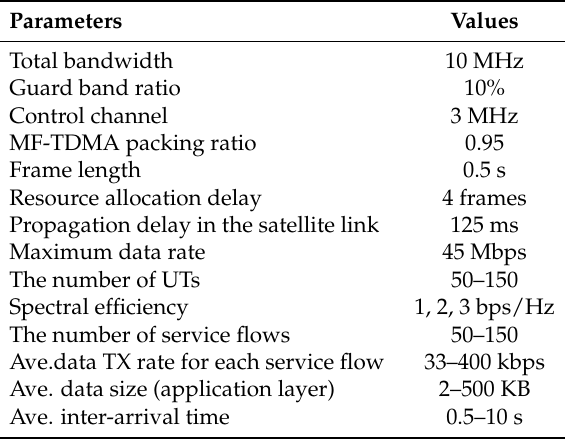
Table 1. The simulation